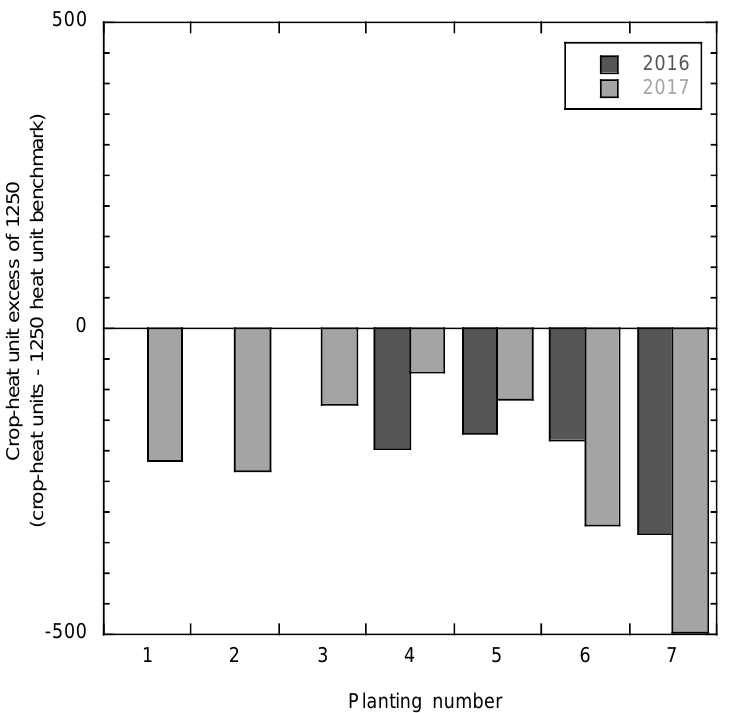
Figure 14. Difference between crop-heat units and the 1250 heat unit benchmark (total crop-heat units − 1250). Data for four plantings in 2016 and seven plantings in 2017. Crop-heat units represent heat units (15.5 °C base) that accumulated between the planting date and the date that the planting reached maturity in each year. Negative values indicate crop-heat unit accumulation was less than 1250.